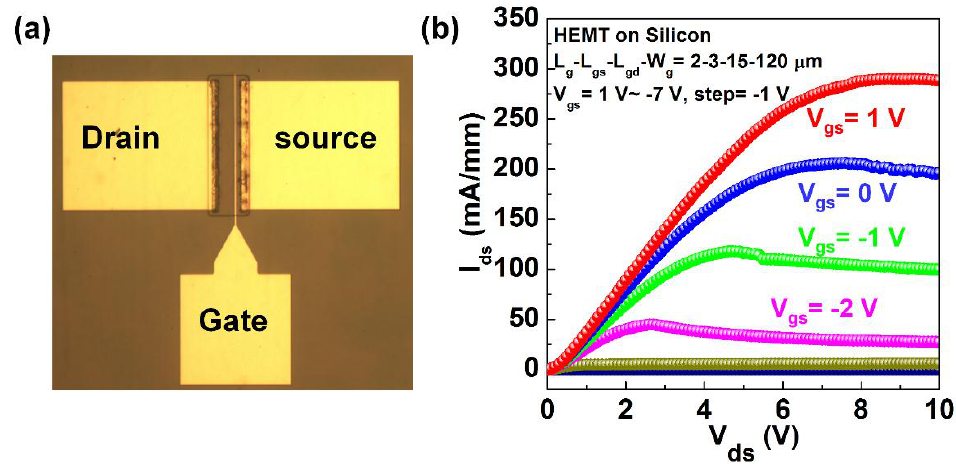
Figure 5. A schematic configuration of the HEMT device ( a ); current–voltage (I-V) as a function of gate voltage ( b ).